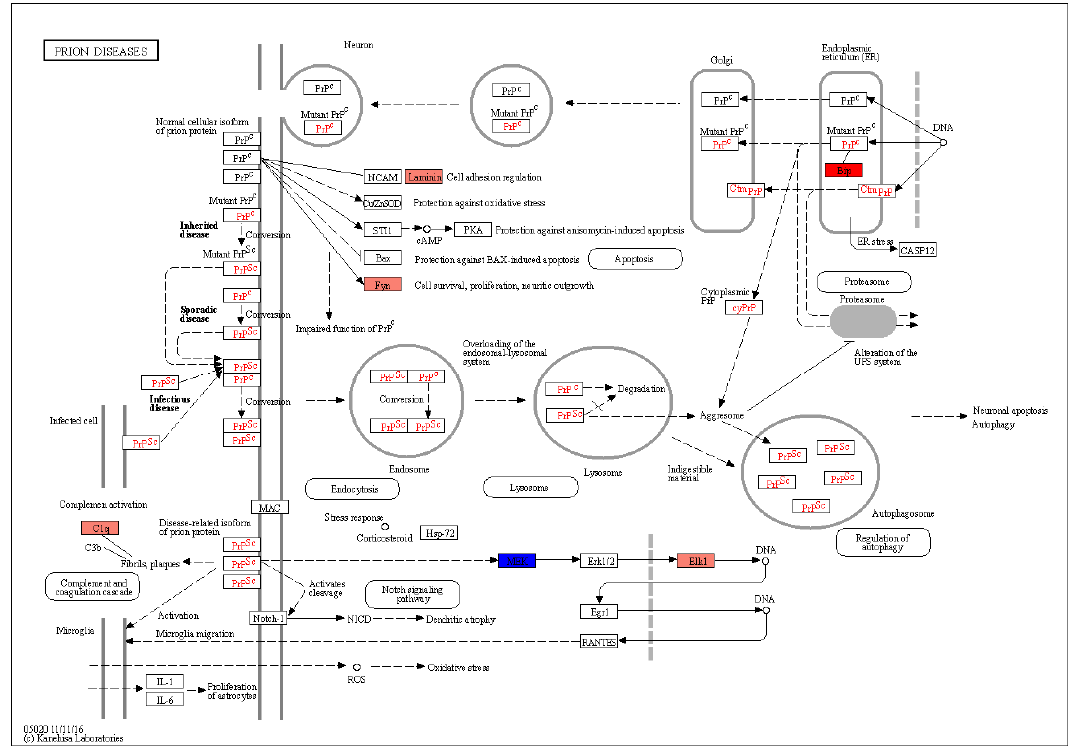
Figure 2. “Prion diseases pathway” from the Kyoto Encyclopedia of Genes and Genomes (KEGG) database with genes significantly modulated in brain samples from ASD patients that have been color-coded from blue (downregulated) to red (upregulated).